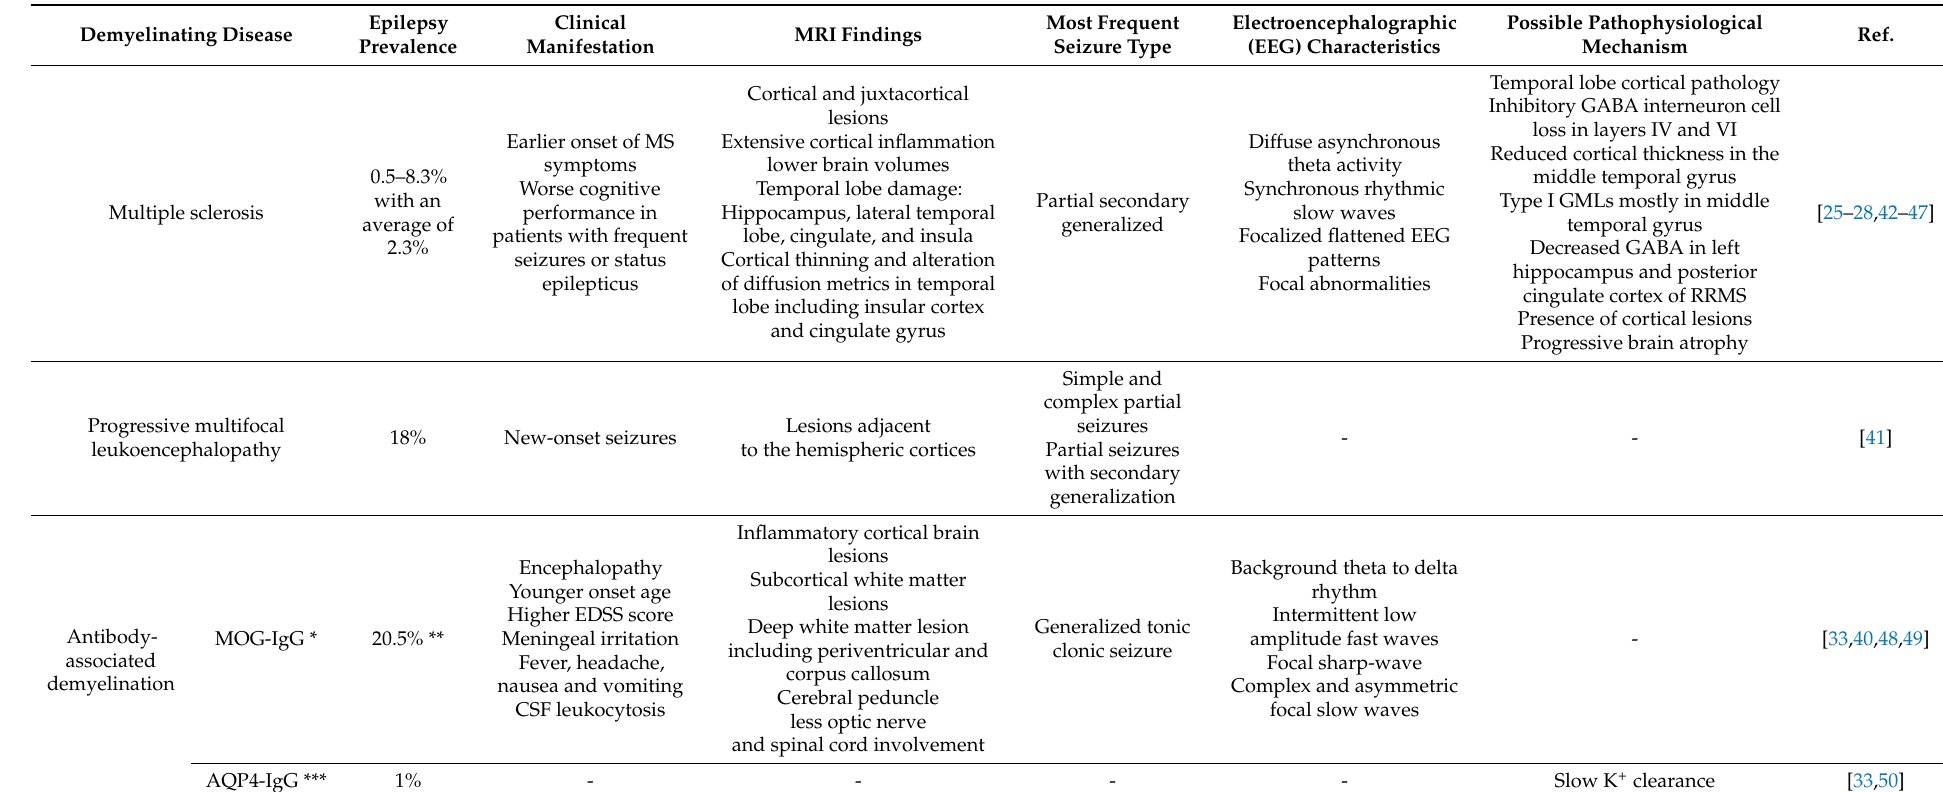
Table 1. Characteristics of patients with seizure associated demyelinating